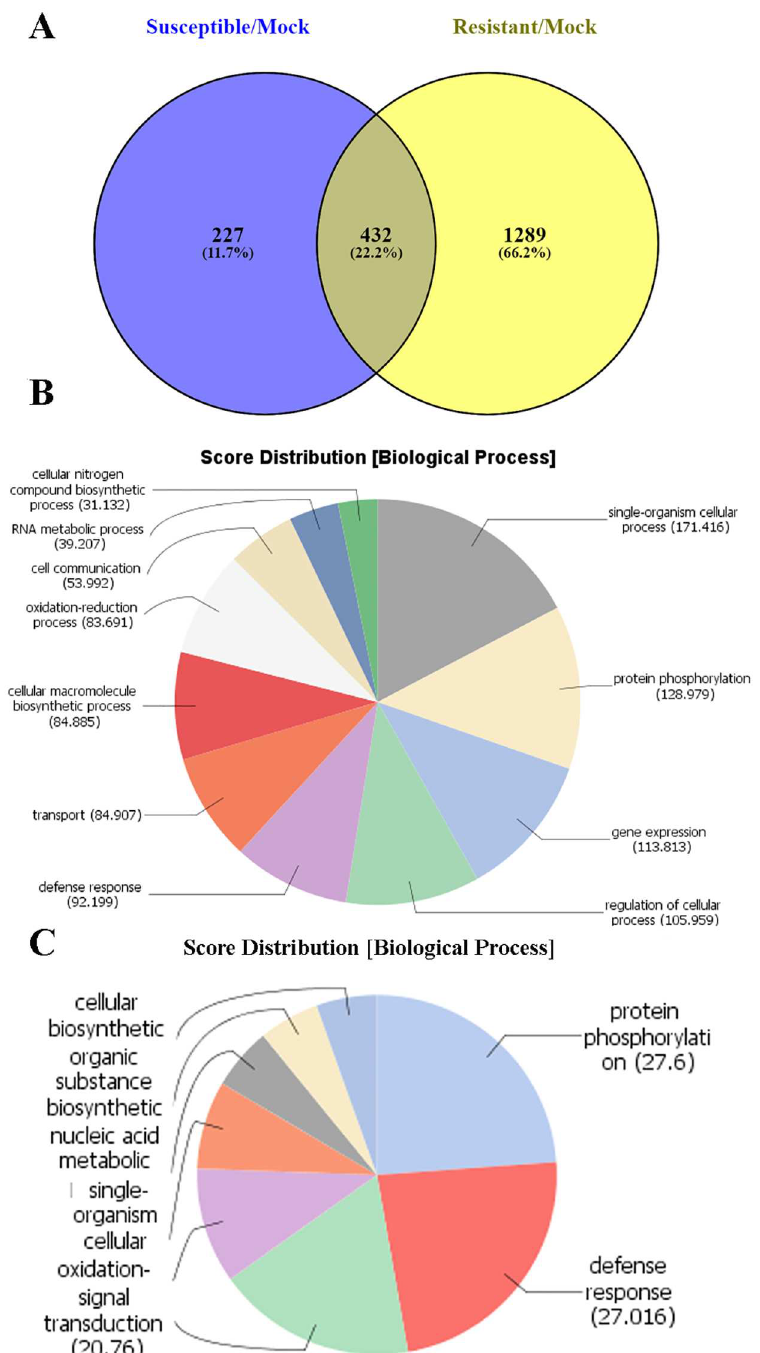
Fig 4. Differentially expressedgenes (DEGs) in alfalfa plants from cultivar ZG9830 in response to inoculation with P . syringae pv. syringae ALF3. (A) Venn diagramdepictinga numberof uniqueand common up-regulated DEGs betweensusceptible and resistant plants at 24 hours after inoculation. (B) Functional categorization of the uniquegenesup-regulated in resistant plants. (C) Functional categorization of the uniqueDEGs inducedin susceptibleplants at 24